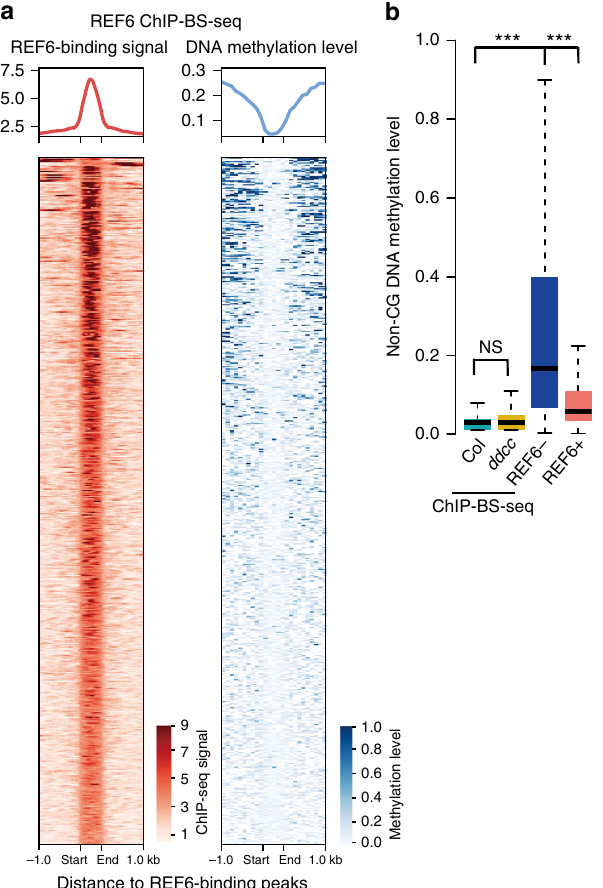
Fig. 2 REF6 prefer to bind hypomethylated regions in Arabidopsis genome. a Heat maps of REF6 occupancy and DNA methylation level in 1.0 kb surrounding REF6-binding peaks. b Box plots showing average non-CG DNA methylation level of in vivo REF6-binding regions. The DNA methylation levels of REF6-binding regions in Col and ddcc are measured by ChIP-BS-seq data, while those in REF6-bound (REF6 + ) and REF6-unbound (REF6 − ) regions are measured by whole genome bisulfate sequencing in Col from WGBS data. In vivo REF6-binding regions and REF6 + show signi fi cant difference (Mann – Whitney U -test, P < 2.2e − 16) to REF6 − motifs. NS, not signi fi cant. The median (center line), interquartile range (IQR; from the 25th to 75th percentile) and the ends of whiskers indicating the minimum and maximum of DNA methylation score from 0 to 1, are shown in the boxplots. Mann – Whitney U -test was used to calculate the P value. *** P <